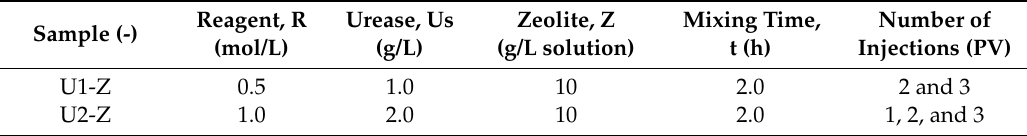
Table 4. Experimental conditions for unconfined compressive strength (UCS) tests. Table 4 . Experimental conditions for unconfined compressive strength (UCS) tests.